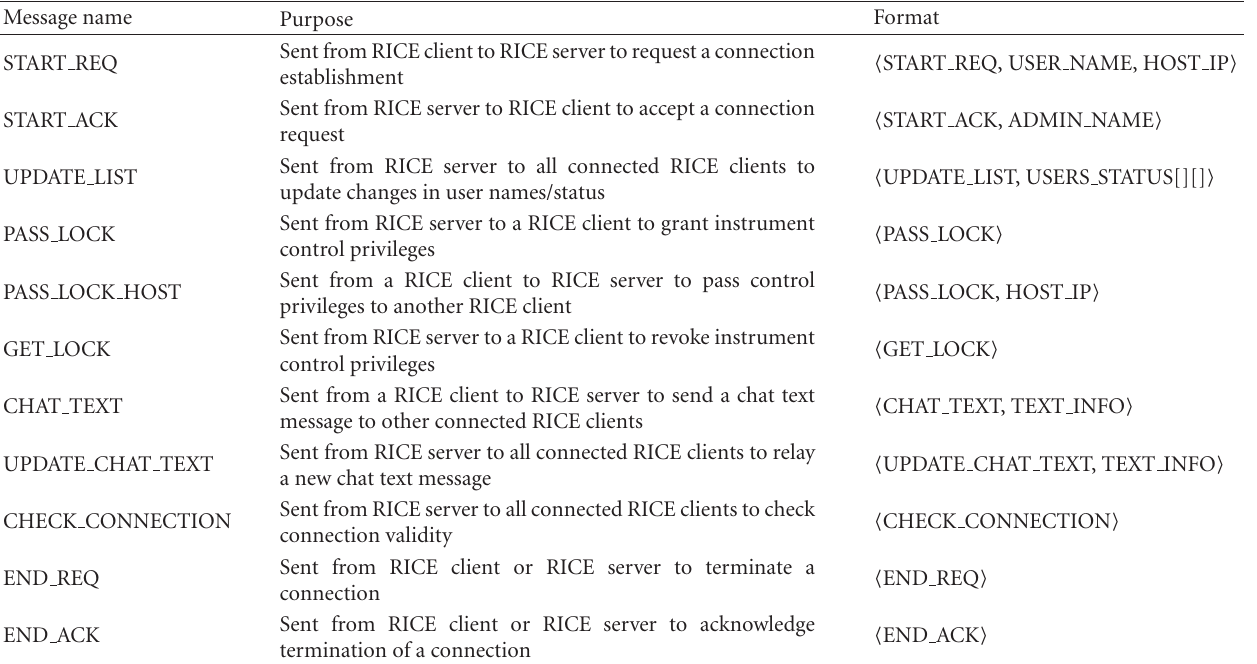
Table 1: List of RICE’s session signaling protocol